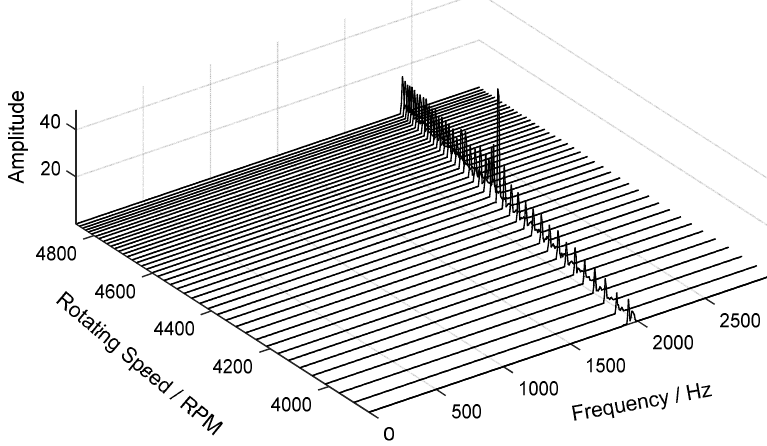
Figure 22. Waterfall of the angular-domain reconstruction signal of the 24th blade.